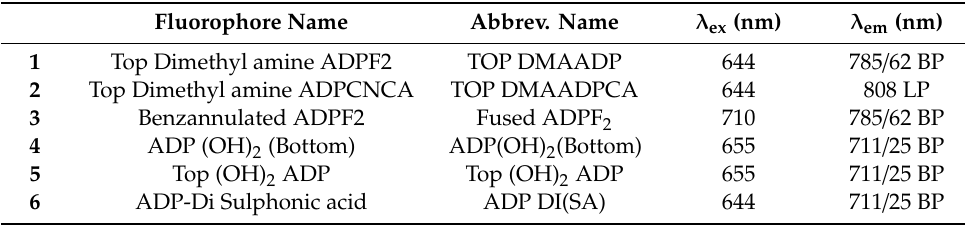
Table 1. Summary of the fluorophores’ names, excitation, and emission detection wavelengths adopted in the experiments [2,14–16] and Supplementary Materials